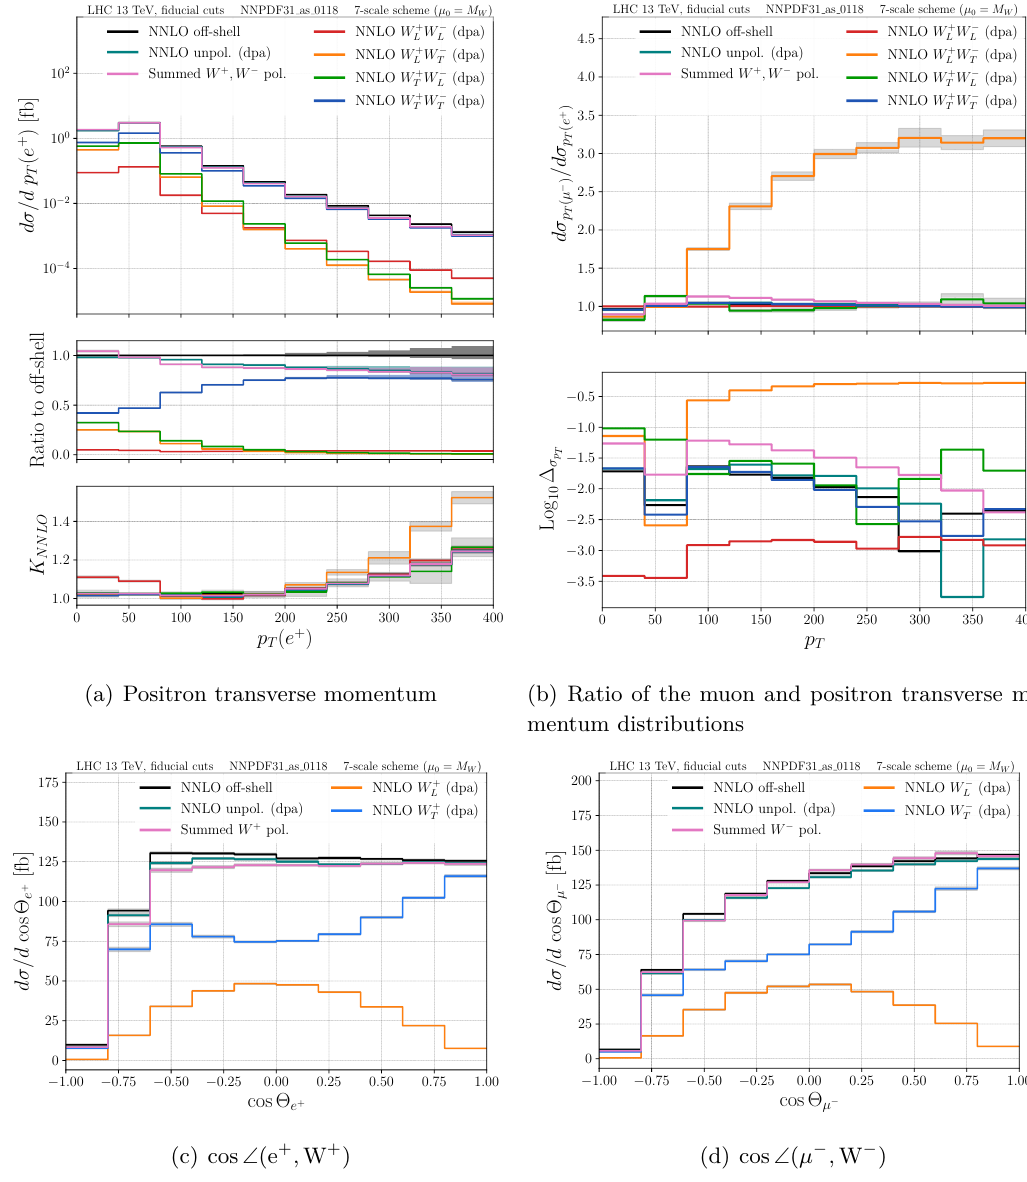
Figure 5 . (Upper row) Distribution of lepton transverse momentum at NNLO (without LI) for e + (left) and its comparison with distribution for µ − (right). Individual plot substructure in (a) is the same as in figure 2. The plot (b) structure is the following: the upper plot features the ratio of muon over positron transverse momenta distributions; the lower plot in (b) features (cid:12) (cid:12) σ pT ( e + ) − σ pT ( µ − ) Log , where σ is the differential transverse momentum distribution. Doubly- (cid:12) (cid:12) p T (cid:12) (cid:12) 10 σ pT ( e + )+ σ pT ( µ − ) polarised setups are shown. (Lower row) Distributions of charged lepton scattering angle cosine calculated in the parent W-boson CM frame at NNLO (without LI) for e + (left) and µ − (right). Par- ent boson singly-polarised setups are shown. Individual plots show the absolute value